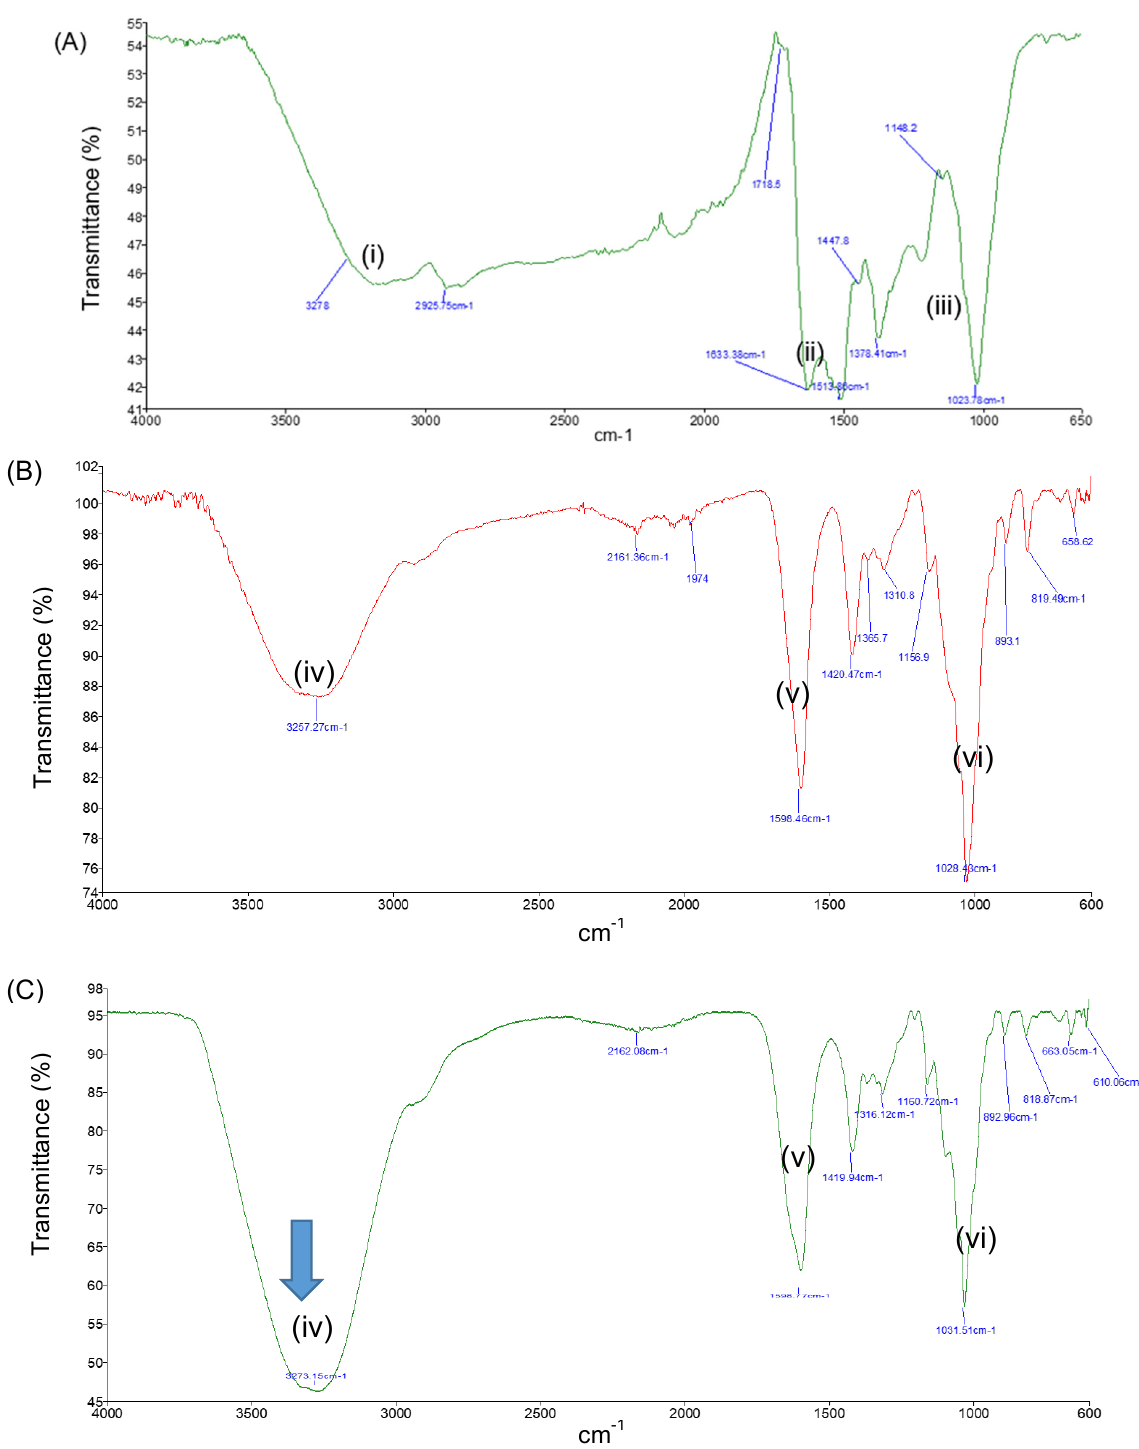
Figure 9. FTIR analysis revealed several characteristic peaks of bioAgNPs ( A ), CNC/Alg ( B ), and bioAgNP/CNC/Alg ( C ). The main characteristic peaks are labeled (i), (ii), (iii), (iv), (v), and (vi).